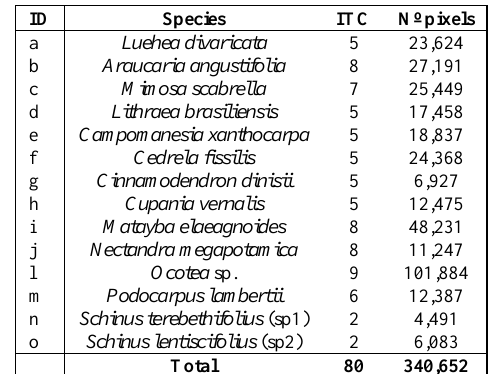
Figure 1. Study area, samples location and ground control points.